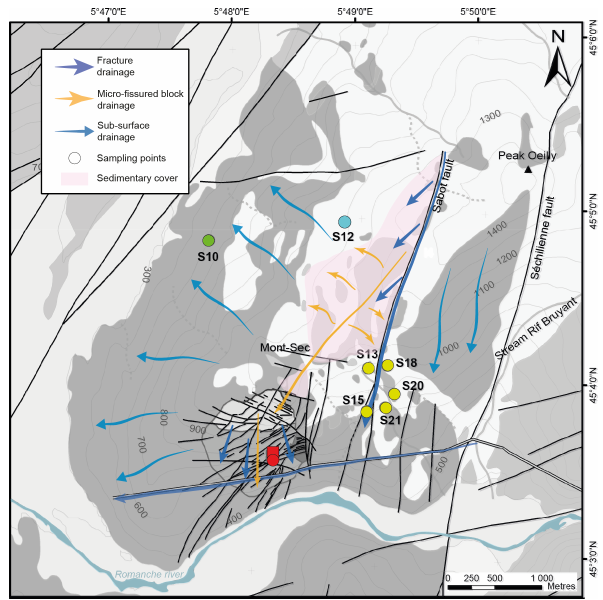
Figure 6. Sketch of the Séchilienne groundwater conceptual model, modified after Vallet et al.